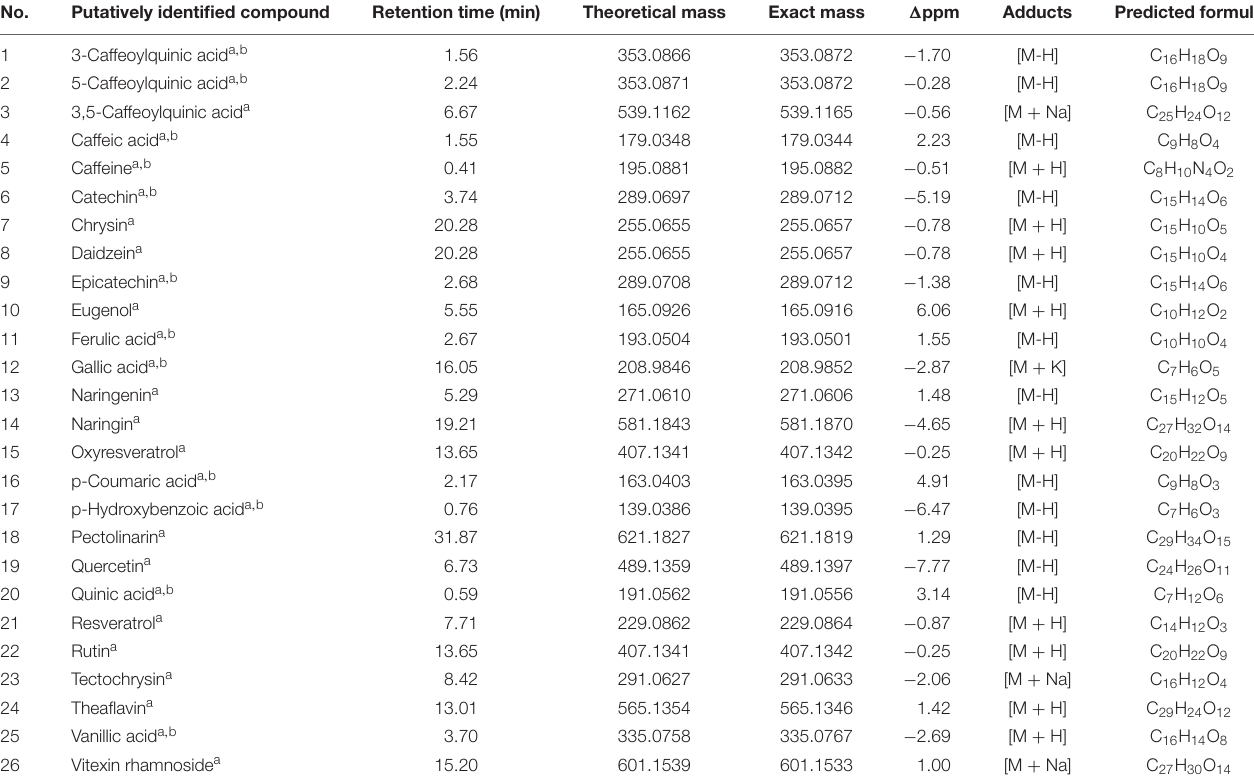
TABLE 1 | Metabolites with known anti-inflammatory activities in spent coffee grounds from three Arabica cultivars via untargeted metabolomics analyses.